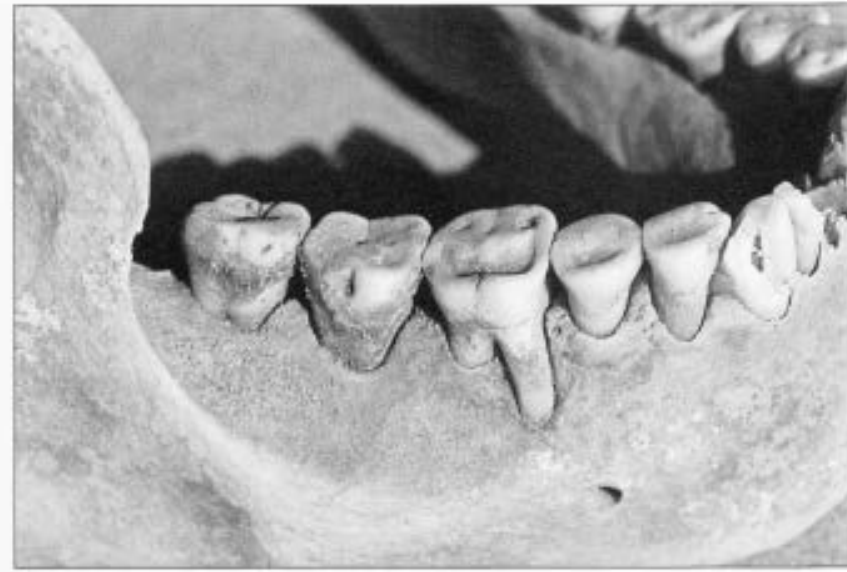
A lower jaw from el Descanso, a Tiwanaku site in the Ilo valley. The wear is still heavy, but much more regular than in Figures 6 and 7. The second molar (second tooth from the left] has a small lesion of dental caries-the dark stained pit in the side of the crown. Some bone has been lost around the roots, and there are moderately heavy deposits of calculus, suggesting the pattern of periodontal inflammation that is possibly associated with coca chewing.